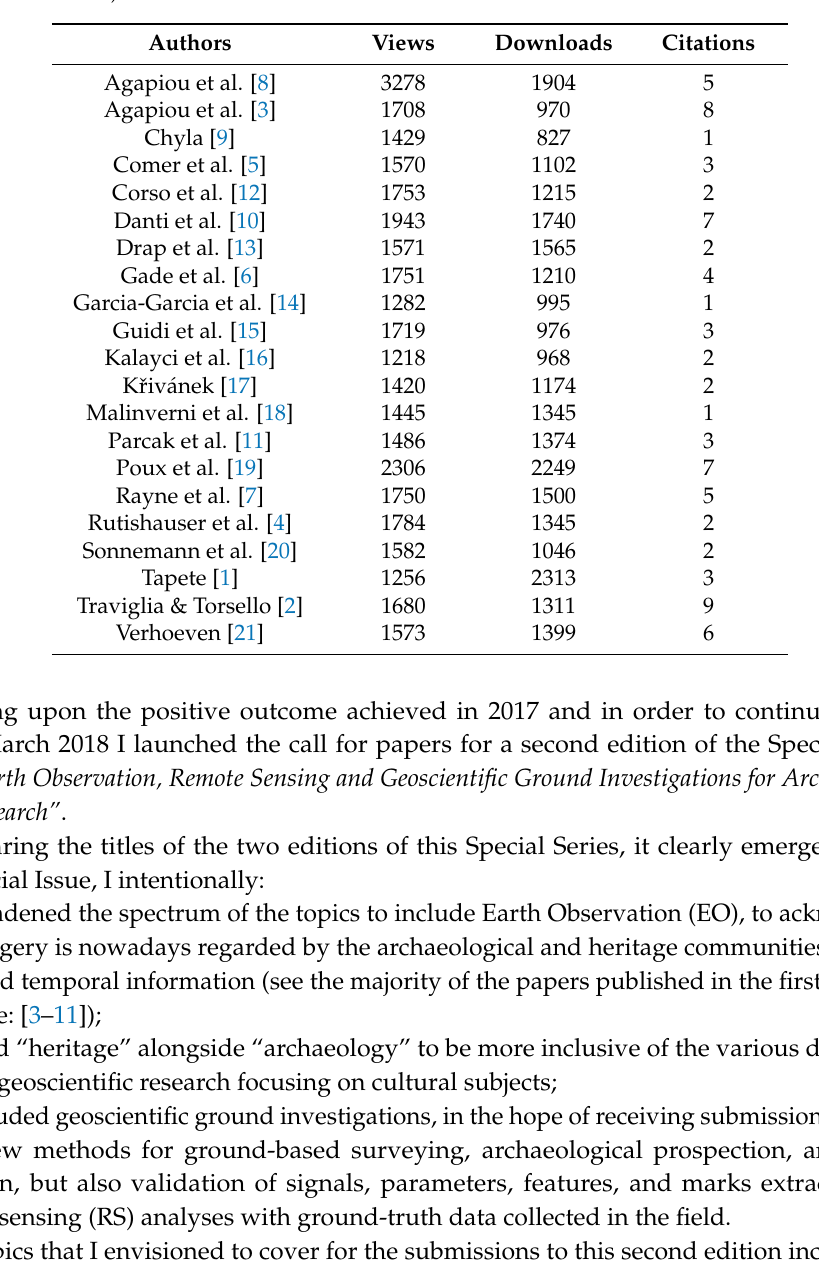
Table 1. Article metrics of the papers published in the first edition of the Special Issue as of 01/04/2019 (source: Geosciences